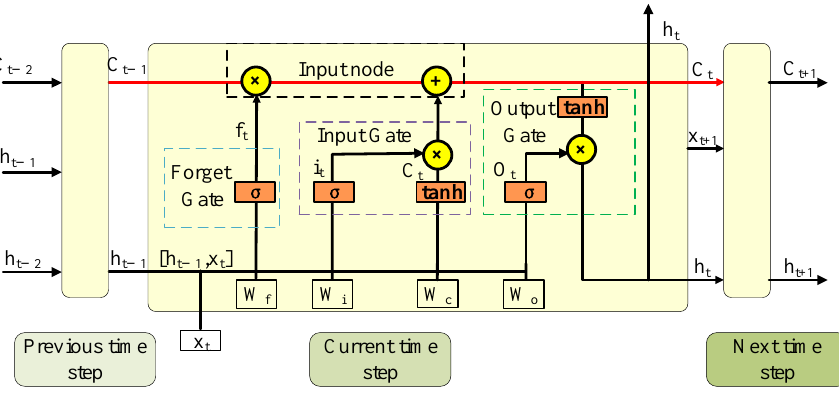
Figure 5. LSTM network structure.